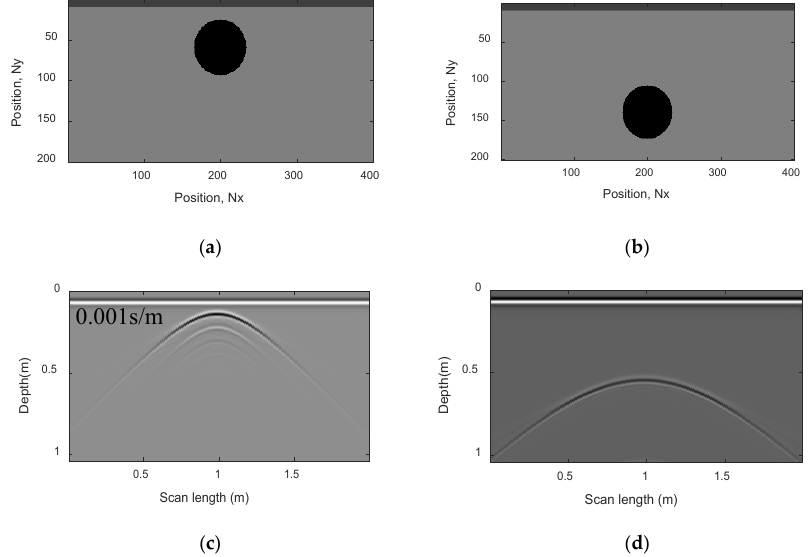
Figure 3. Simulation results( a , b ) models of two conductive objects buried in a medium of wet sand at a depth of 0.3 and 0.7 m ( c , d ) object detection radargrams.